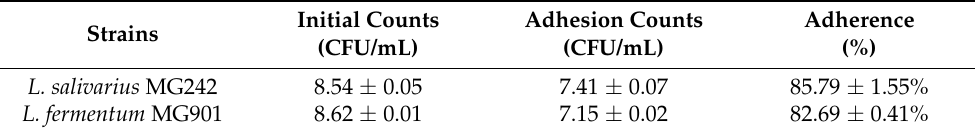
Table 2. Adhesion of L. salivarius MG242 and L. fermentum MG901 to HT-29 colorectal cells.